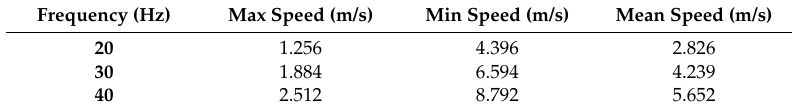
Table 2. Speeds of the samples as a function of rotation frequency and distance from the axis.